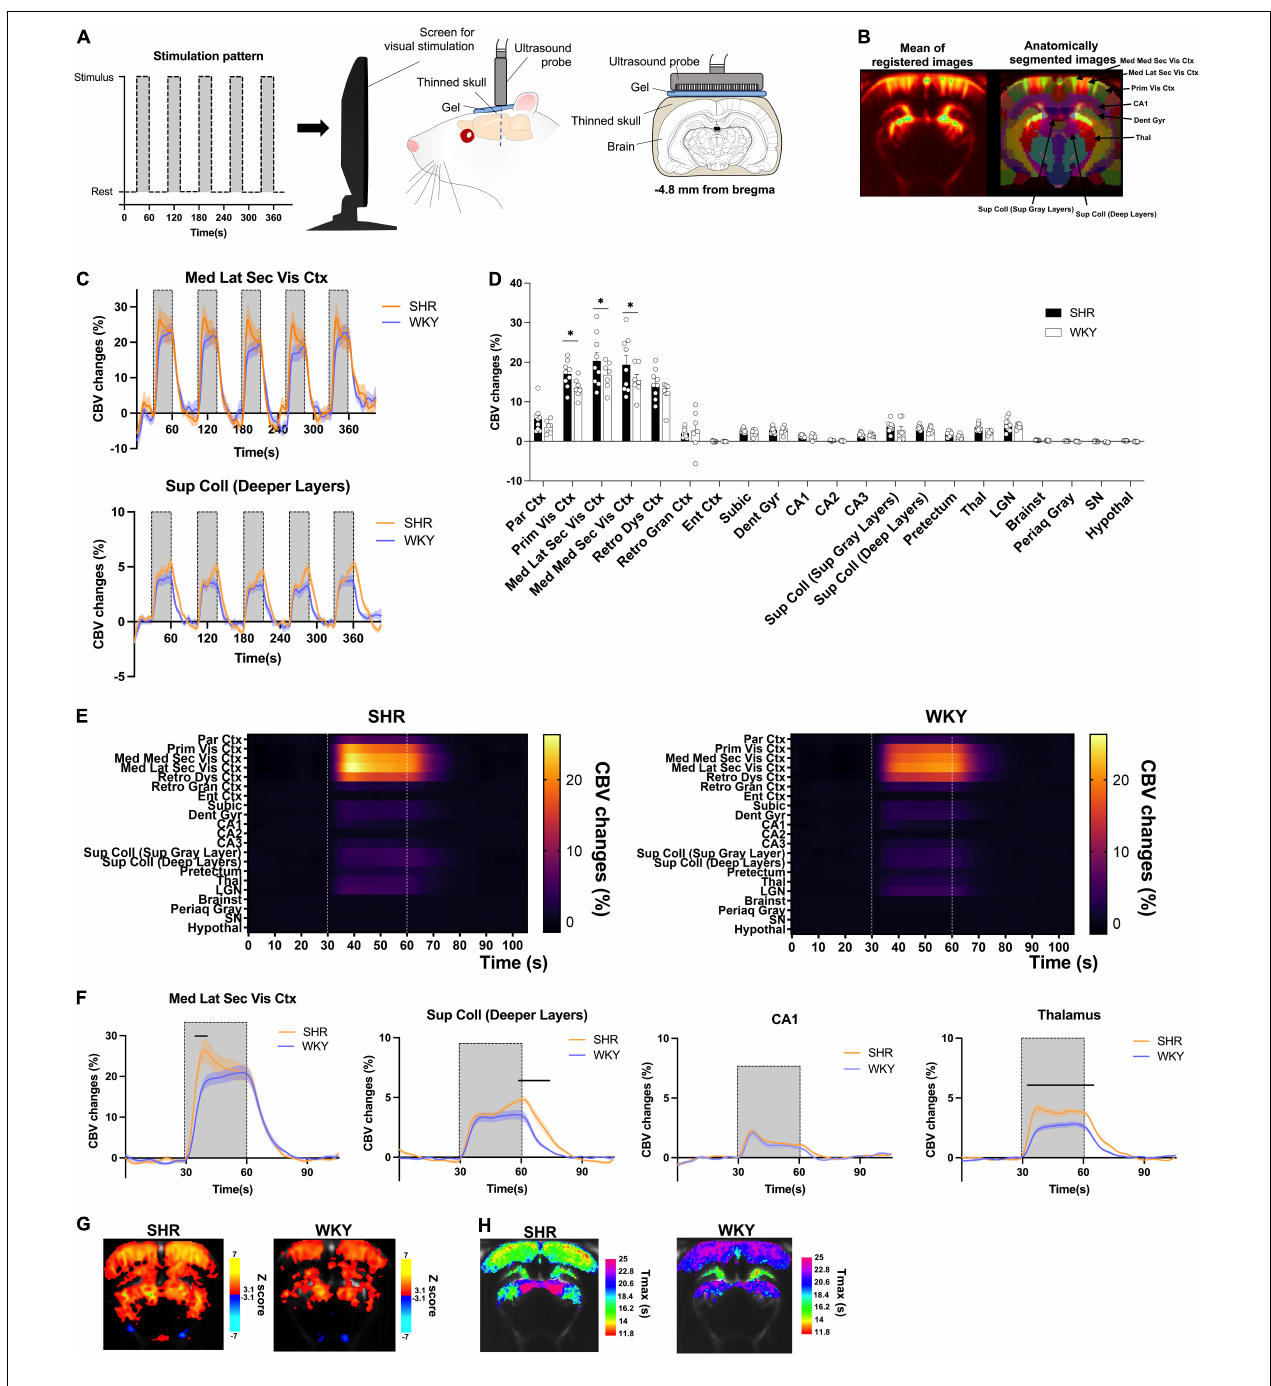
FIGURE 1 | Functional Ultrasound Imaging (fUS) responses to visual stimulation in WKY and SHR rats. Functional ultrasound acquisition during visual stimulation (A) . (B) Mean of registered images during a fUS session (left) and overlay of an anatomical atlas (right) for all animals. Some regions of interest are shown for better understanding of the main results. (C) Time curves of CBV changes in the mediolateral secondary visual cortex (upper) and superior colliculus (lower). Visual stimulation periods are shown by horizontal lines ( n = 7–9 rats per group; mean ± SEM) (D) mean CBV changes during the five stimulation periods in the different regions of interest (mean ± SEM). Two-way ANOVA followed by multiple comparisons correction with an FDR of 0.1 (*). (E) Visual response time curves over the five stimulation periods in all ROIs. Visual stimulation periods are shown by vertical dotted lines. (F) Mean time curves of CBV changes during all five stimulation periods in the mediolateral secondary visual cortex (top left), superior colliculus (top right), CA1 of the hippocampus (bottom left), and thalamus (bottom right). Significant differences between SHR and WKY rats are show by horizontal bars. Two-way repeated-measures ANOVAs followed by Sidak’s multiple comparisons tests ( p < 0.05, mean ± SEM) (G) statistical pixel-based analysis of the visual stimulation response as compared to non-stimulated period ( p < 0.001). (H) Temporal profile of the visual stimulation response, with a pixel-to-pixel mapping of the mean time to maximal CBV increase during the five stimulations in all animals for each group.